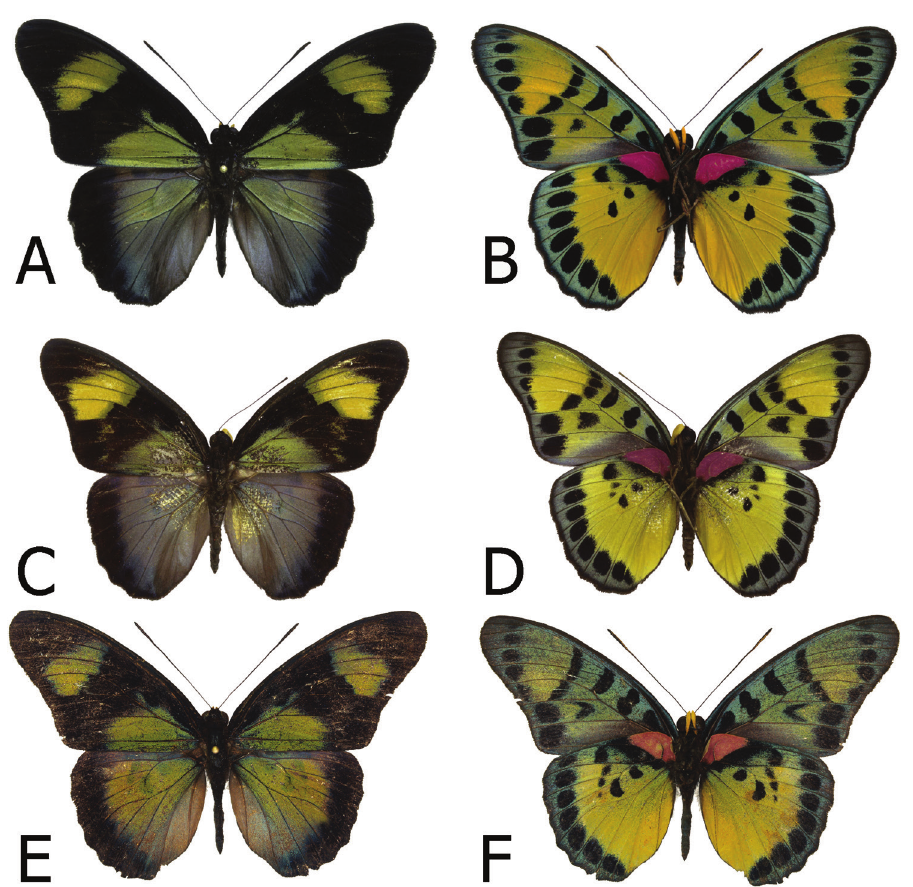
Figure 2. Adults, males: A E. cyparissa aurantina Bibiani, Ghana, holotype (dorsum) B E. cyparissa aurantina Bibiani, Ghana, paratype (venter) C E. cyparissa aurata Isheri, Nigeria (dorsum) D E. cyparissa aurata Isheri, Nigeria (venter) e E. cyparissa nominalina Mongoumba, R. C. A., holotype (dorsum) F E. cyparissa nominalina Mongoumba, R. C. A., holotype